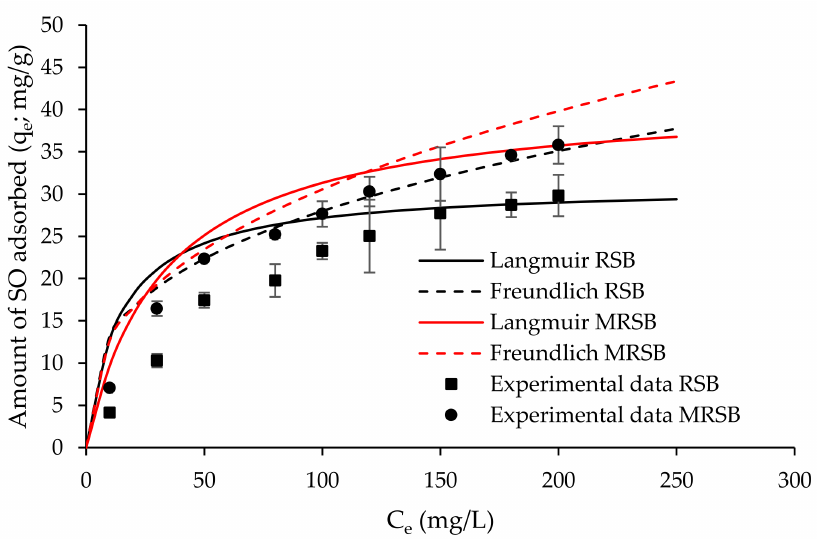
Figure 5. Langmuir and Freundlich isotherm of SO adsorption on RSB and MRSB (Experimental conditions: C 0 = 10–200 mg/L, m adsorbent = 2 g/L, t = 240 min, pH